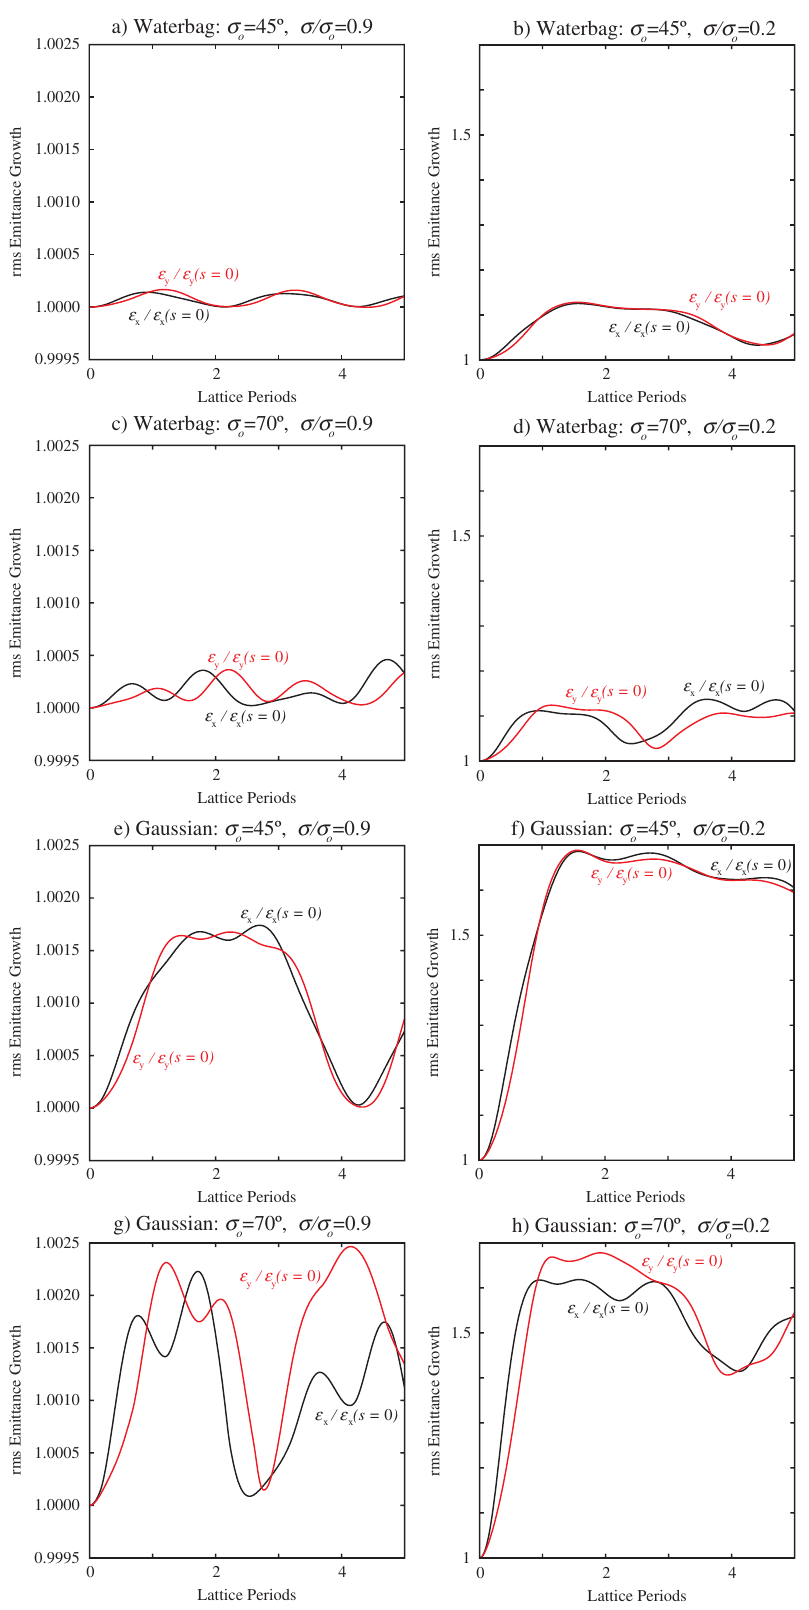
FIG. 4. (Color) Evolution of the beam rms-edge emittances " in Fig.